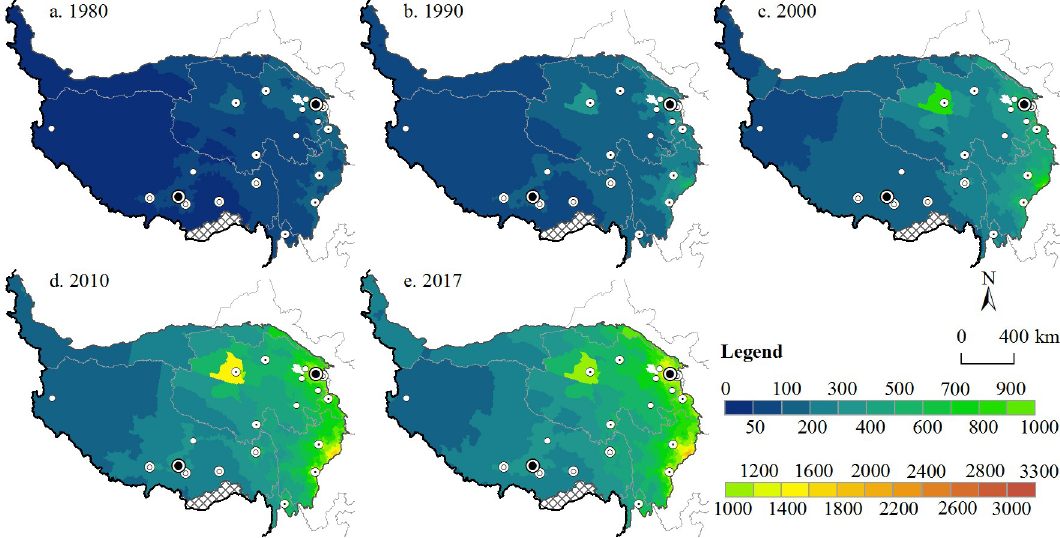
Fig 3. Spatial patterns and changes in potential accessibility at the township scale.